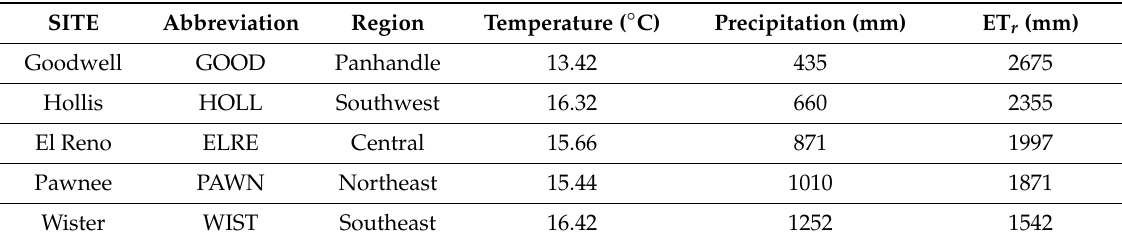
Figure 1. Normal annual precipitation in Oklahoma (1981–2010). Source: PRISM raster map. The locations of study sites and major rivers are also demonstrated. Table1. Annualaveragedailyairtemperature, totalprecipitation, andtotalreferenceevapotranspiration (ET r ) measured at each study site over the study period